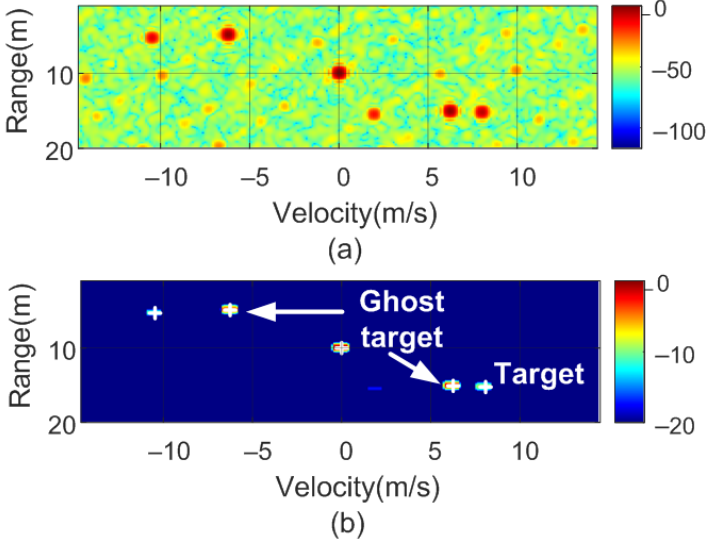
Figure 24. Simulated range–Doppler map ( a ) and after CFAR detector ( b ) with a real target at 15 m and 8